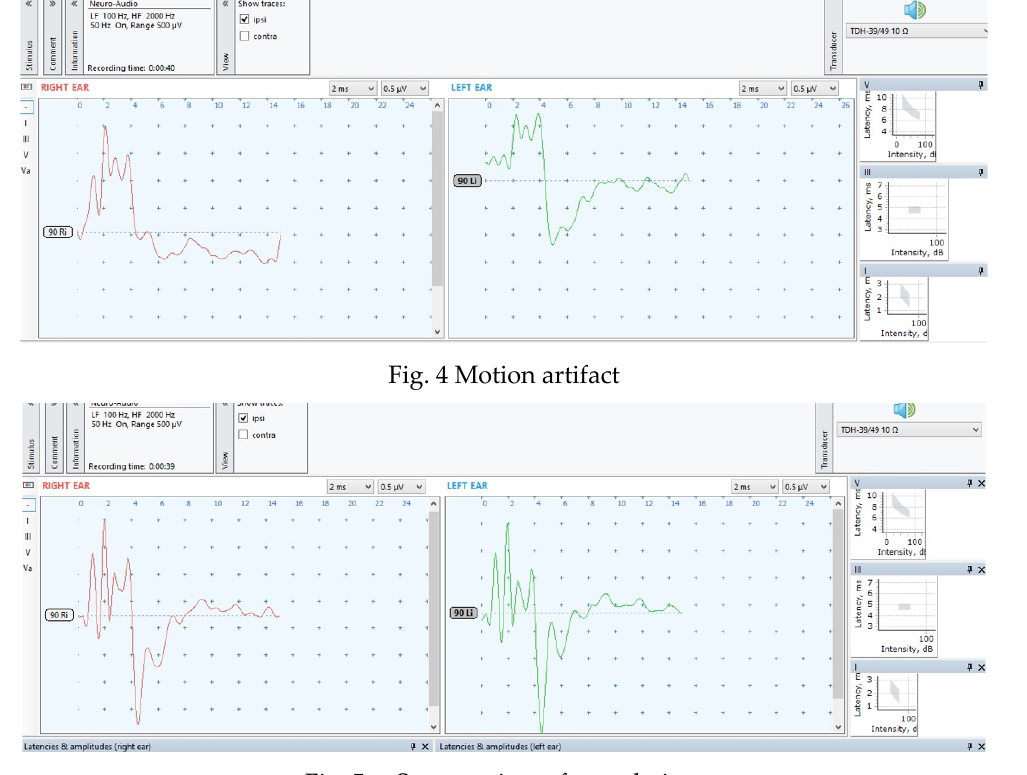
Fig. 5. Same patient after